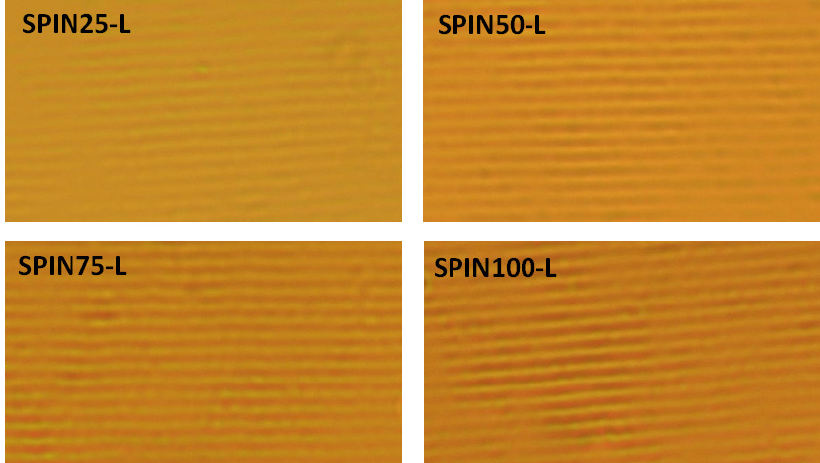
Figure 6. Optical microscopy pictures of the laser-exposed PI-based supramolecular systems.